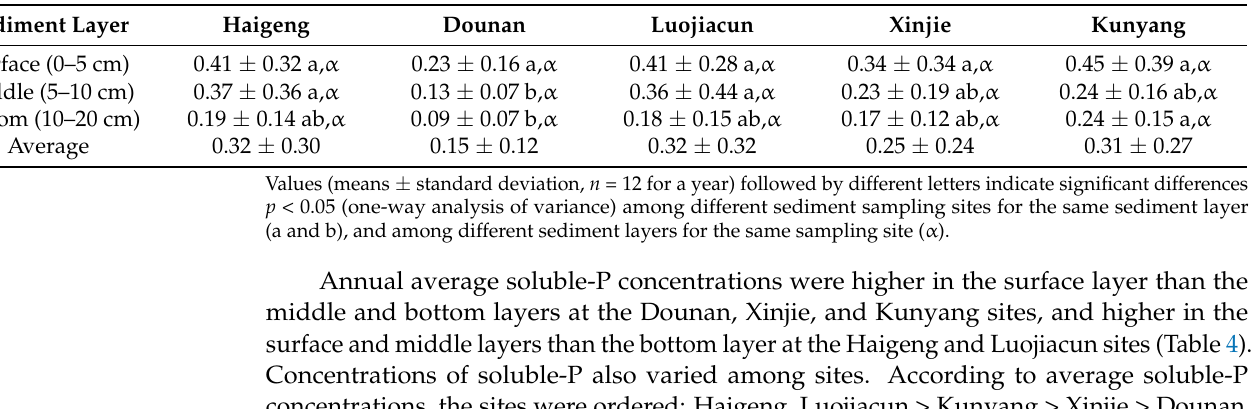
Table 4. Spatial variation in soluble-P in sediment of Dianchi lake (P mg kg − 1 ).